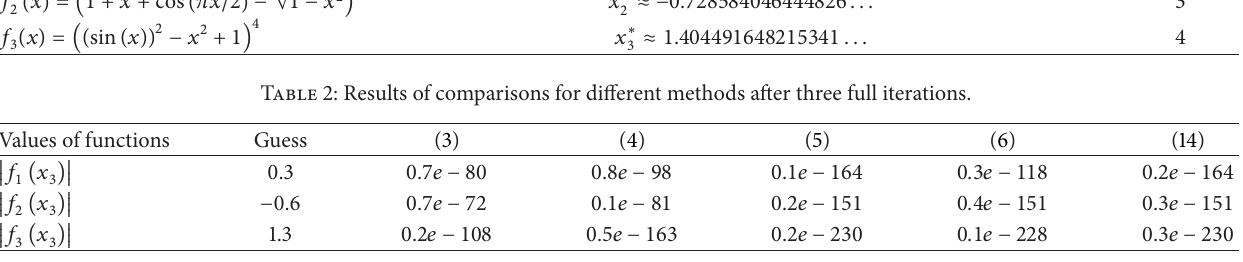
Table 3: Results of comparisons for different methods after three full